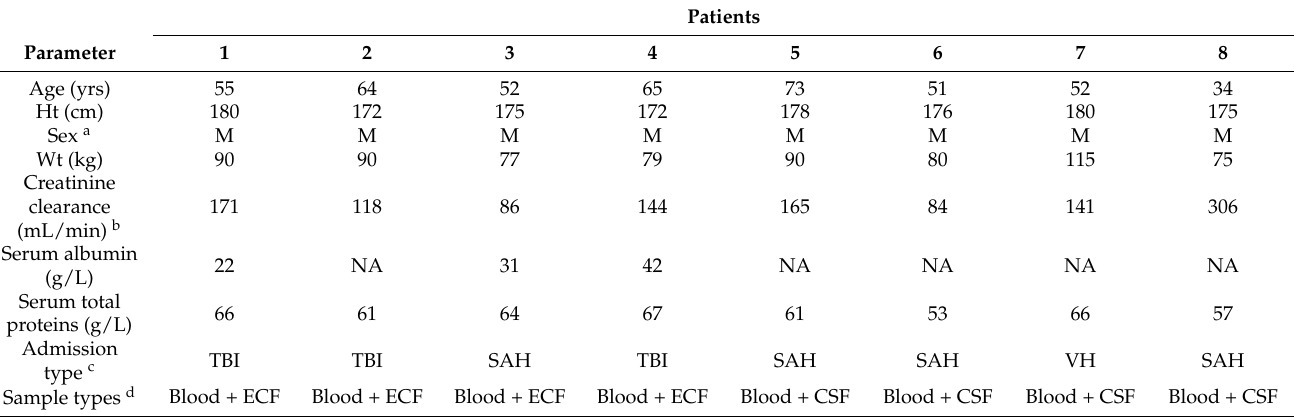
Table 3. Demographic characteristics of